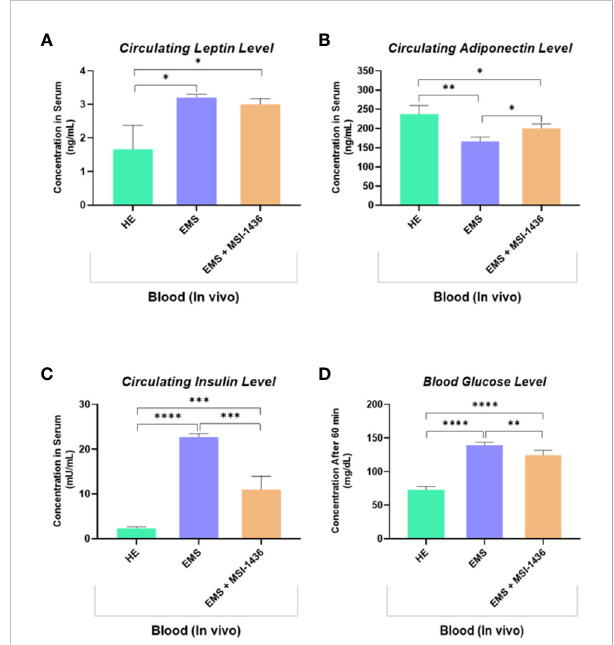
FIGURE 8 Circulating levels of key insulin resistance related metabolic parameters determined following in vivo application of MSI-1436 inhibitor. Blood levels of Leptin (A) , Adiponectin (B) , Insulin (C) and Glucose (D) were determined in healthy, EMS untreated and EMS treated horses. Data are presented as a mean value obtained from measurments ± SD. Statistical signi fi cance was marked as follows: *p-value < 0.05; **p < 0.01, ***p-value < 0.001 and ****p-value <